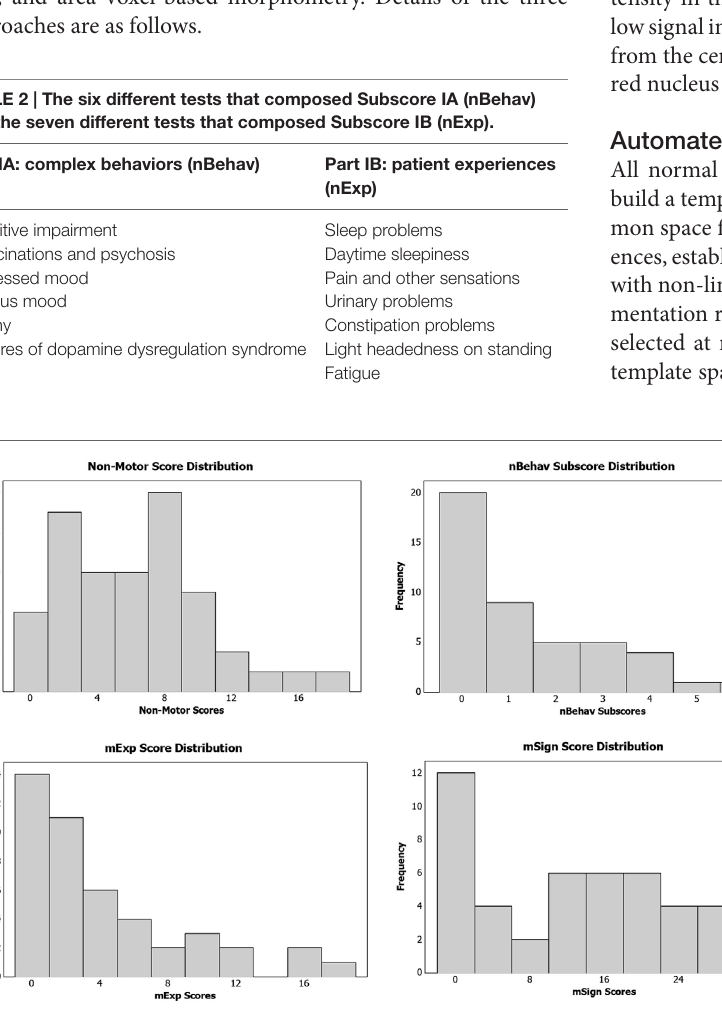
FigUre 1 | Distribution of clinical MDs-UPDrs data